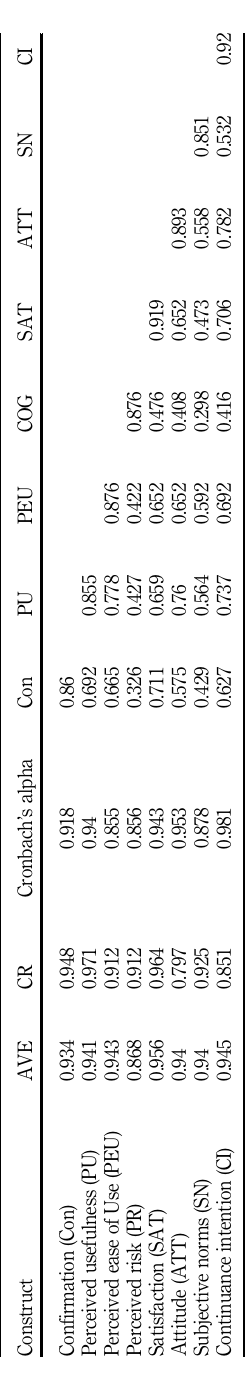
Table 2. Construct